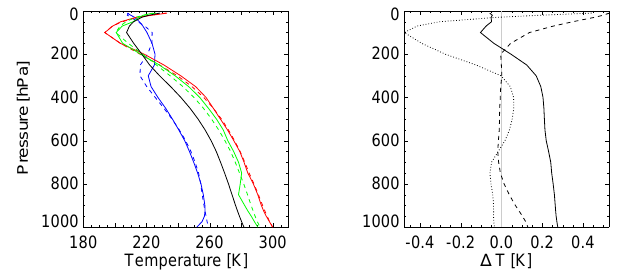
Fig. 1. Left panel: the mean profile ( T mean , black), three arbitrary temperature profiles (solid lines) and their reconstruction (dotted lines) using the three most significant eigenvectors. Right panel: first (solid), second (dotted) and third (dashed)